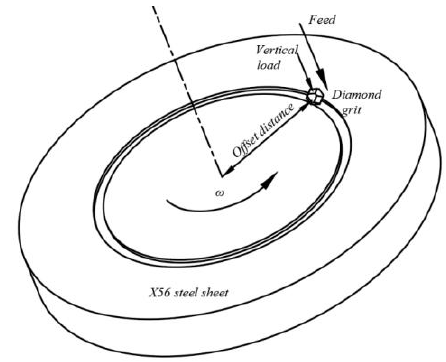
Figure 7. Principle of tribometer.